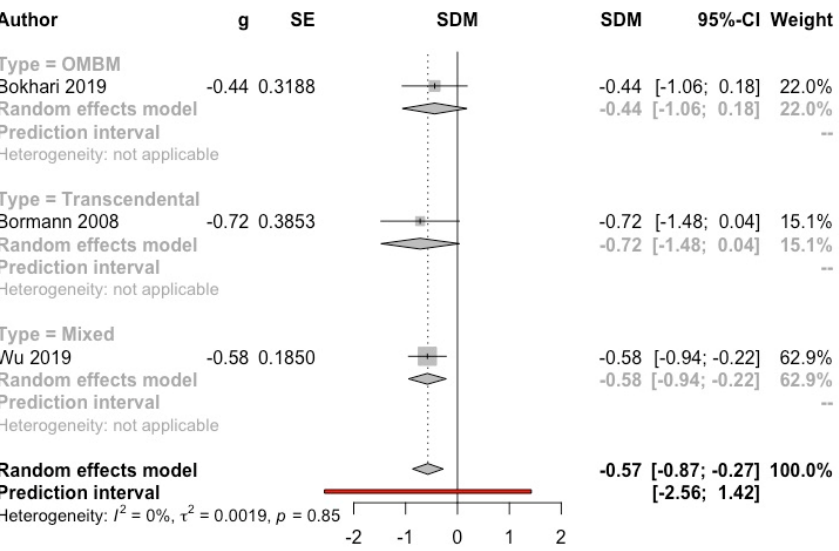
Figure 11. Effect on general psychopathology (meditation vs. control). Predictive intervals are represented in red.